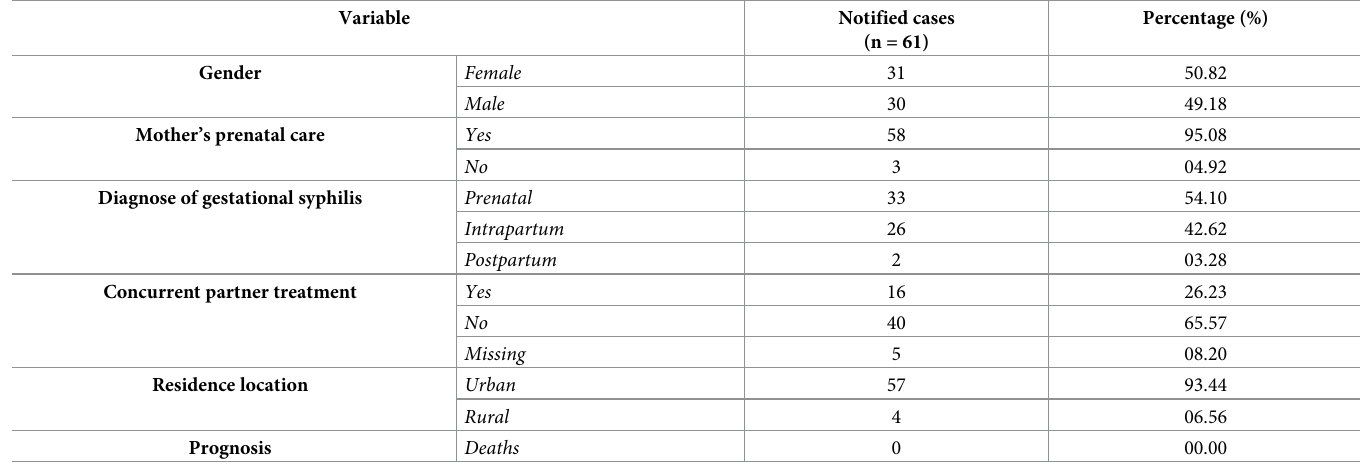
Table 3. Variables related to cases of mother-to-child transmission (MTCT) of syphilis notified from 2007 to 2013 in cities located in the Pontal do Paranapanema region. A total of 61 cases of MTCT of syphilis were notified. In 58 of those (95.08%) mother was assistance during pre-natal period and 33 (54.10%) were diagnosed with gestational syphilis (GS) at this period. Diagnosis in intrapartum and postpartum of GS were, respectively, determined in 42.62% and 3.28% of the women in the region. None of cases of MTCT of syphilis lead to death in this region. Database: National System of Aggravations and Notification—SINAN